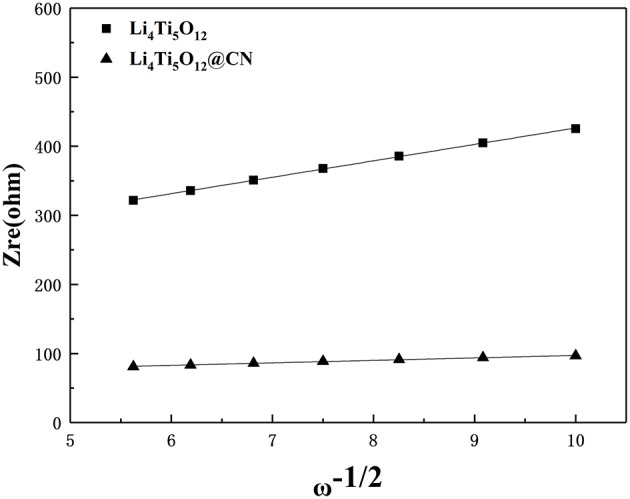
Relation Zre and ω−1/2 in between at the low frequency region.